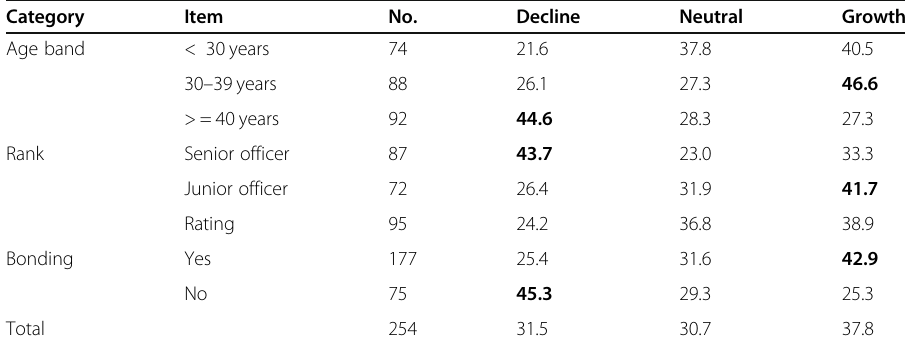
Table 11 Views on the future of Chinese exporting seafarers Category